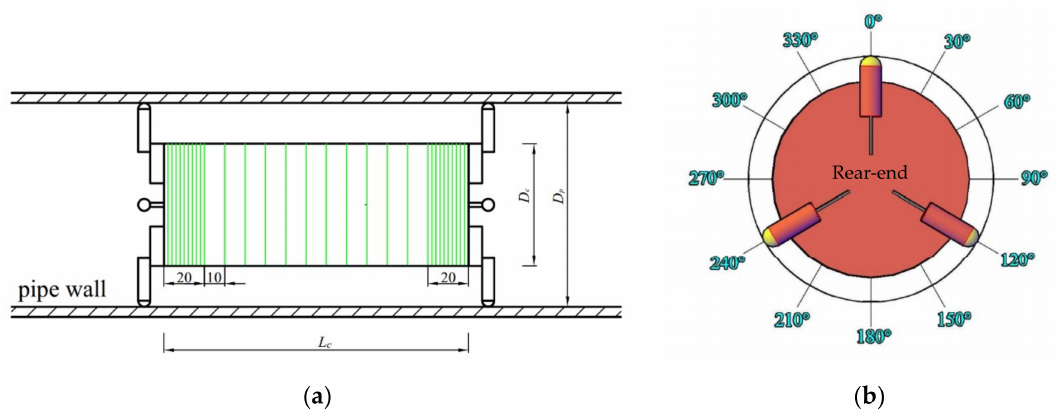
Figure 6. The layout of measuring points near the cylinder wall of piped carriage. ( a ) Layout of test section around cylinder; ( b ) Distribution of measuring points on each test